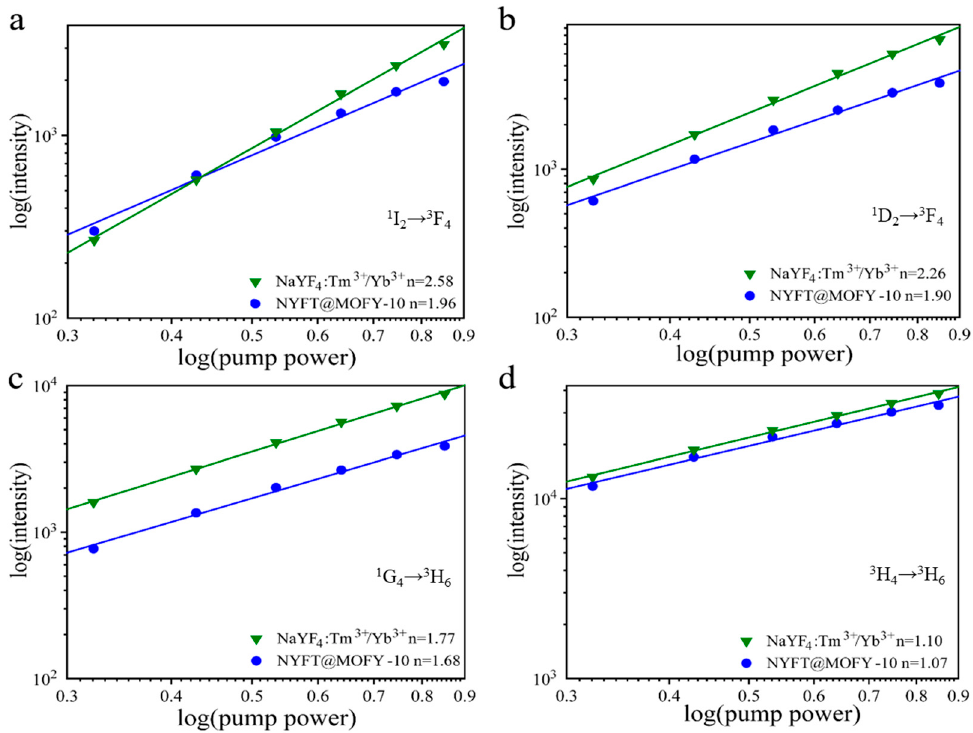
Figure 5. Plots (log–log) of the emission intensity versus pump power density for different samples ( a ) 1 I 2 → 3 F 4 (Tm 3 + ), ( b ) 1 D 2 → 3 F 4 (Tm 3 + ), ( c ) 1 G 4 → 3 H 6 (Tm 3 + ), and ( d ) 3 H 4 → 3 H 6 (Tm 3 + ). at ( a ) 1 I 2 → 3 F 4 (Tm 3+ ), ( b ) 1 D 2 → 3 F 4 (Tm 3+ ), ( c ) 1 G 4 → 3 H 6 (Tm 3+ ), and ( d ) 3 H 4 → 3 H 6 (Tm 3+ ). To further investigate the anti-stokes mechanism of NaYF 4 : Tm 3+ /Yb 3+ and NaYF 4 :Tm 3+ /Yb 3+ @MOF-Y:Eu 3+ nanocomposites, the UV ( 1 I 2 → 3 F 4 ), visible ( 1 D 2 → 3 F 4 , 1 G 4 → 3 H 6 ), and IR